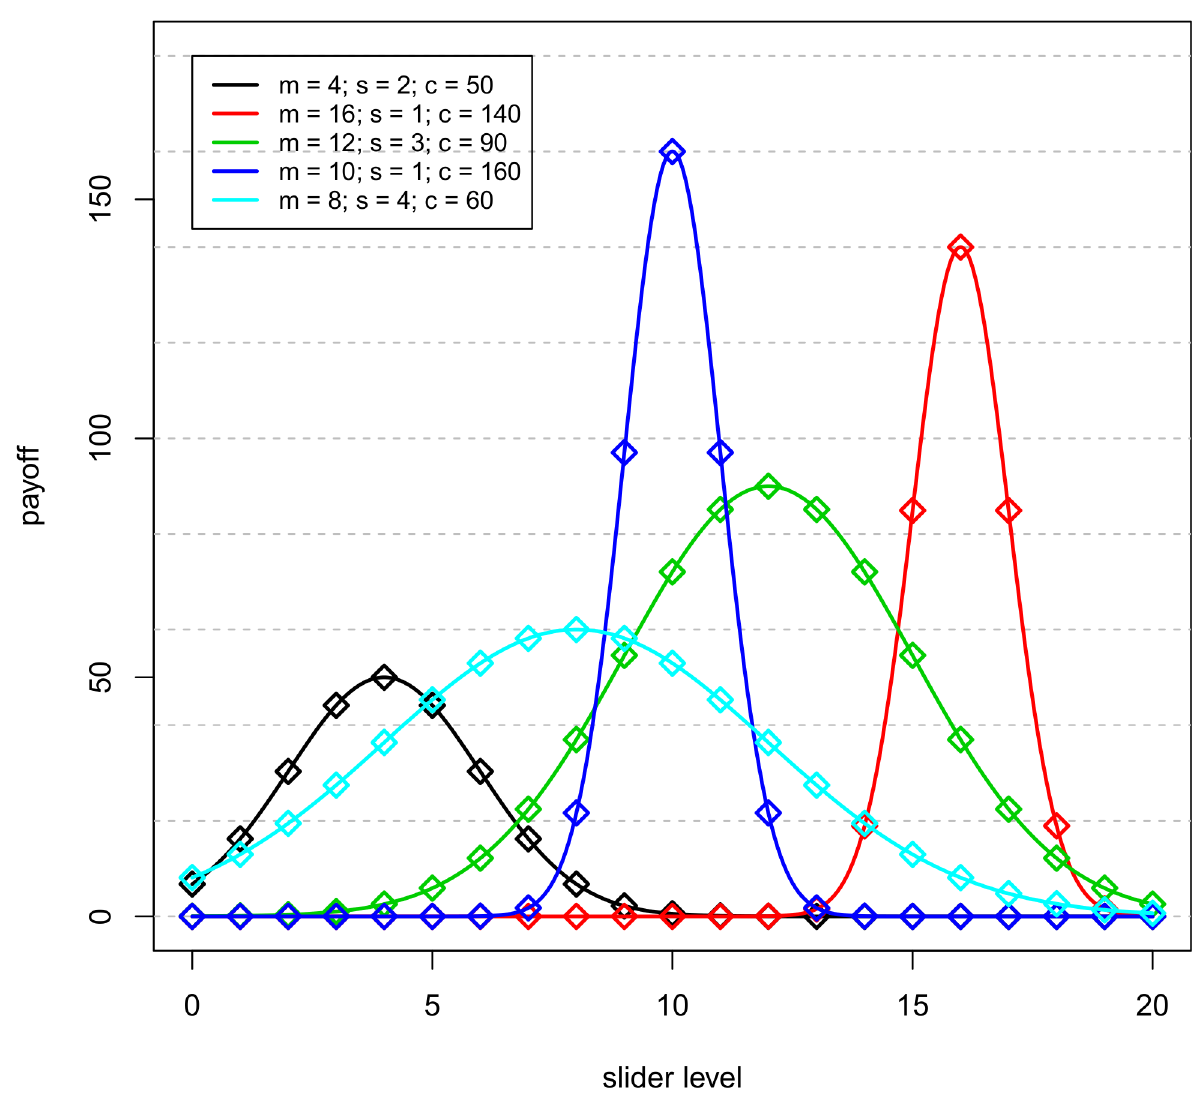
Fig 1. Sliders’ payoff